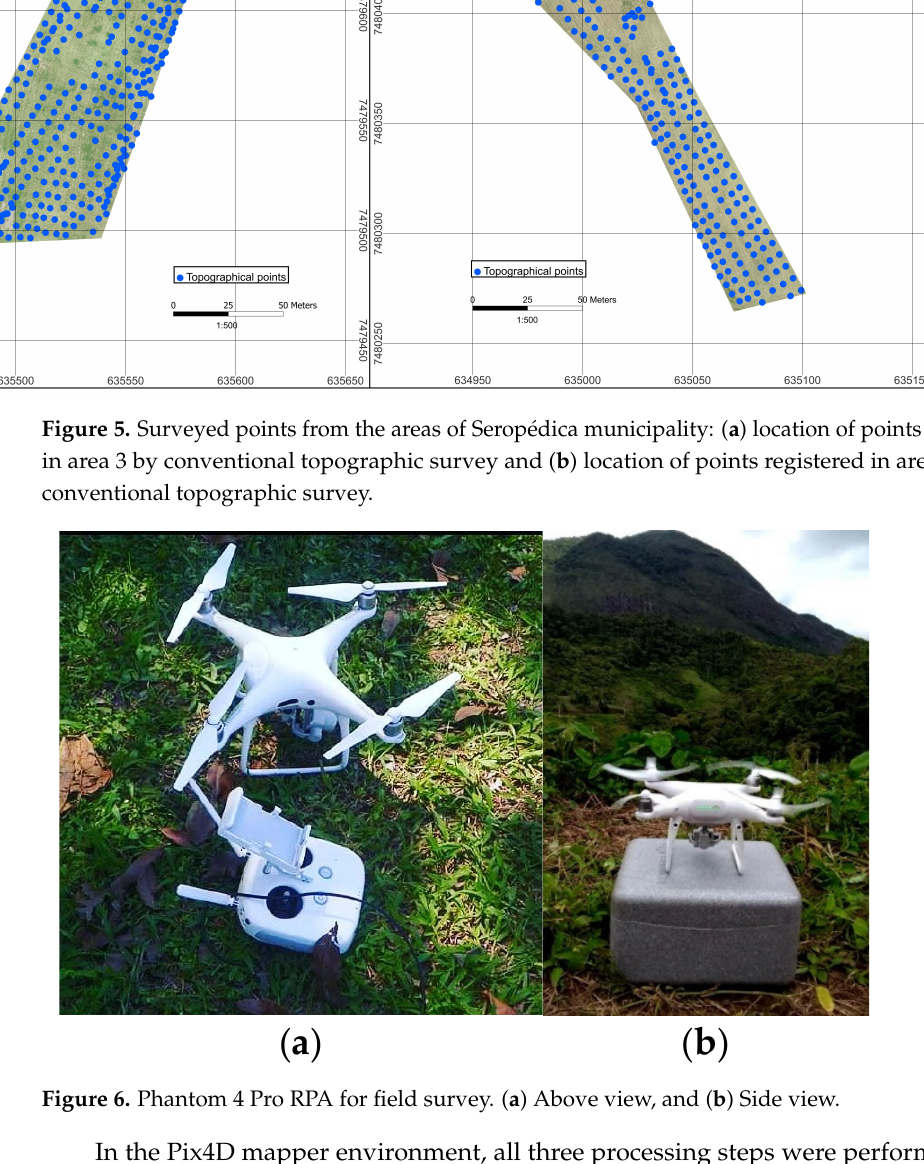
the insertion of their respective